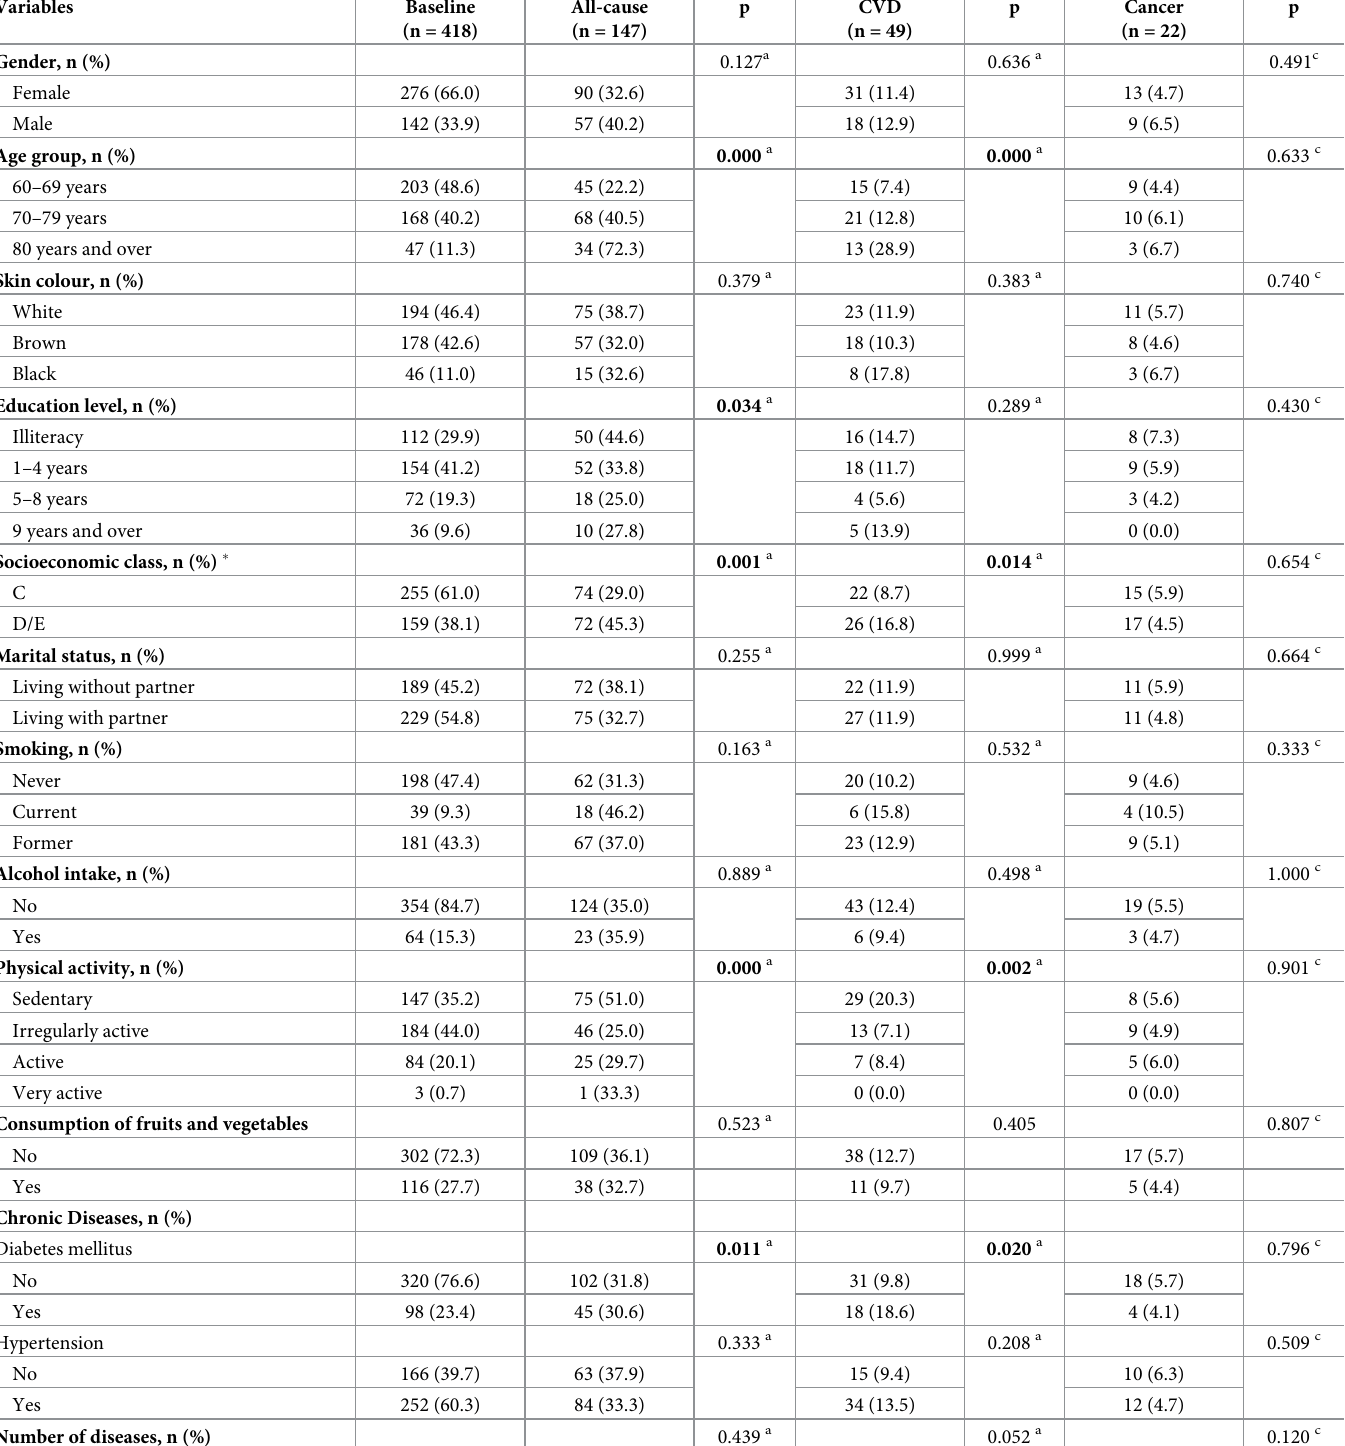
Table 1. Baseline characteristics of participants stratified by all–cause, CVD and cancer